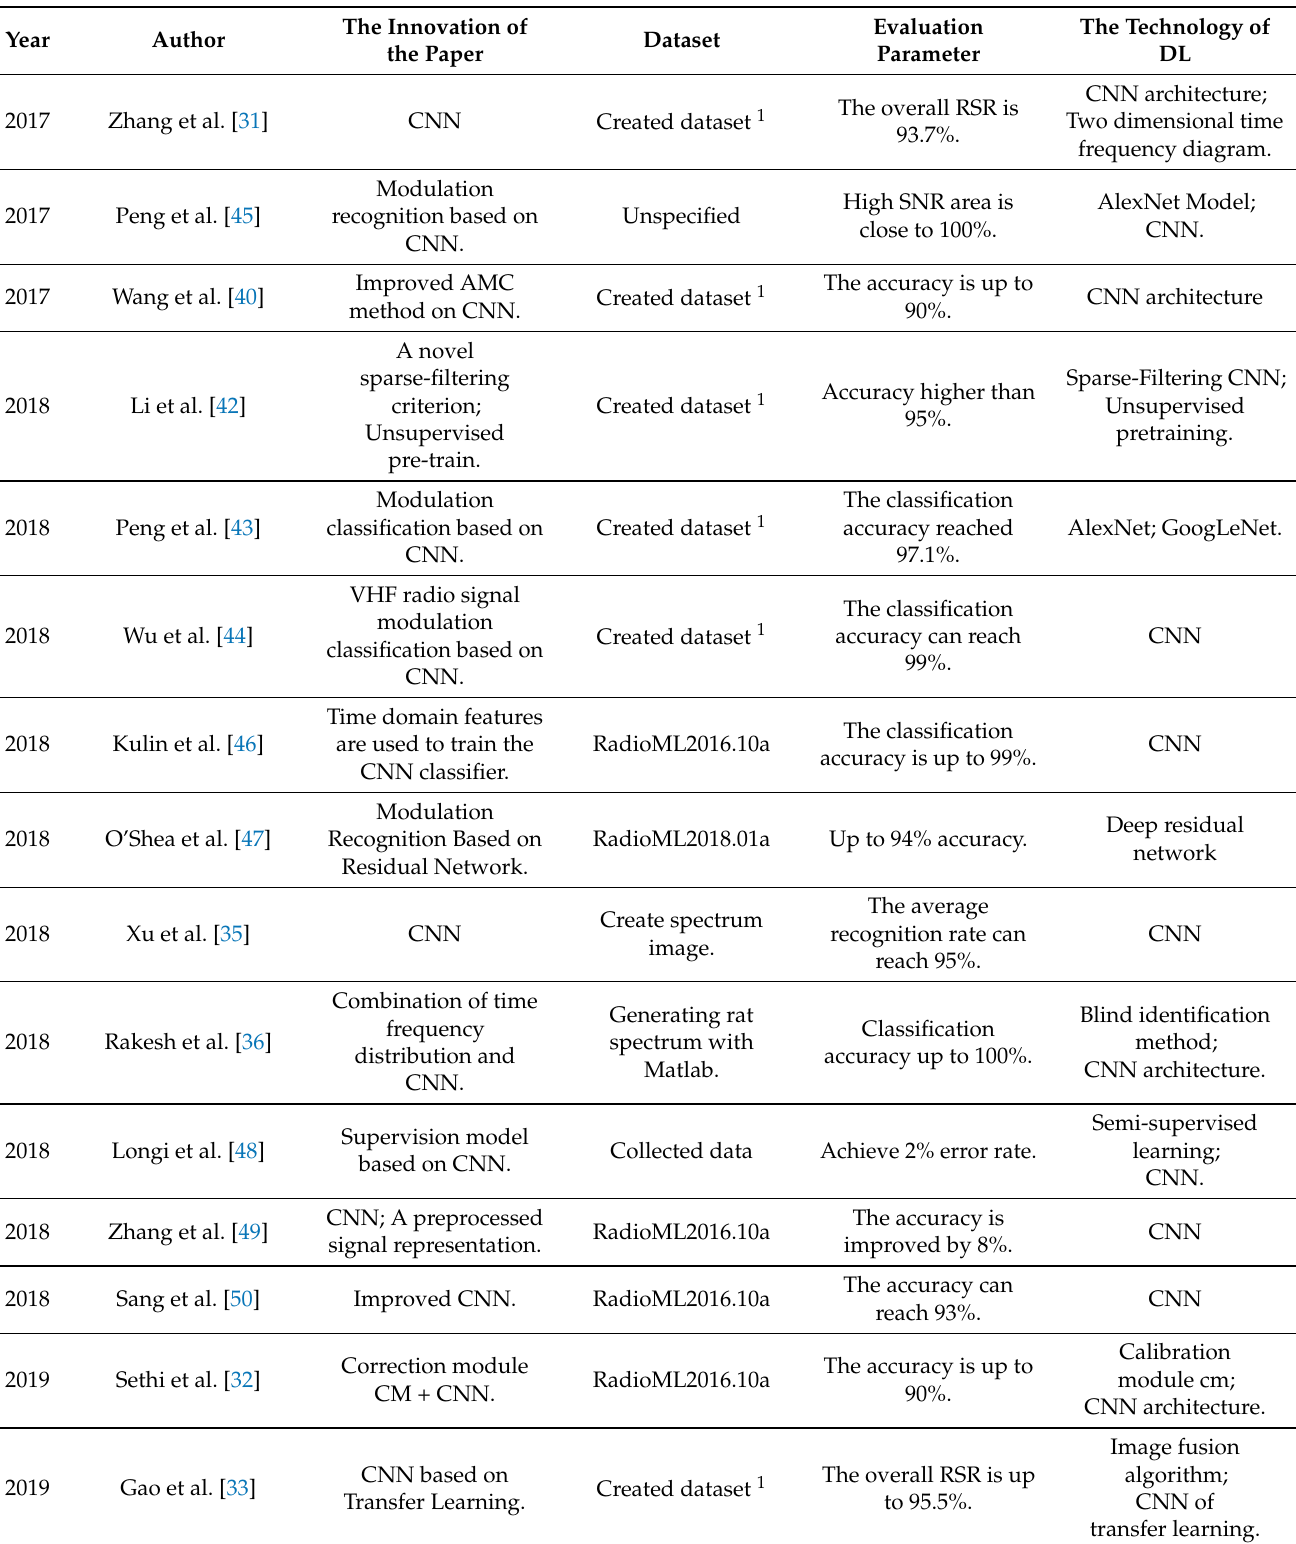
Table 2. Radio modulation recognition networks based on